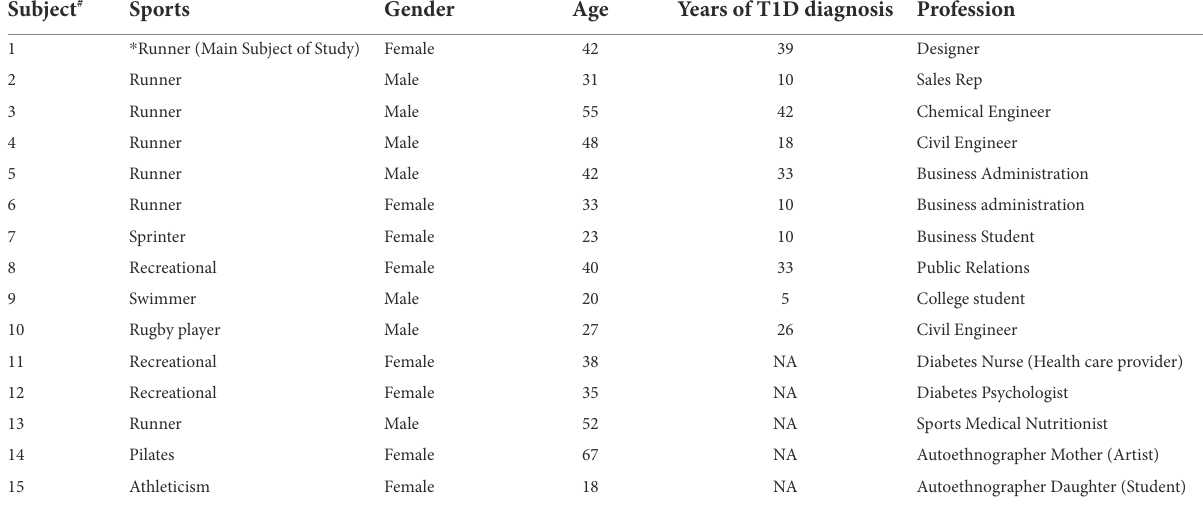
TABLE 1 Characteristics of subjects enrolled in this